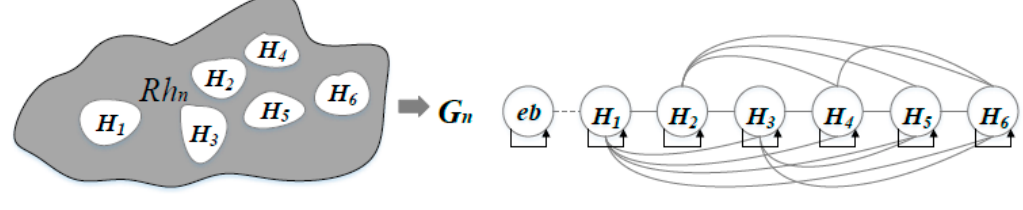
Figure 9. Expression graph of the constraints of Rh n .